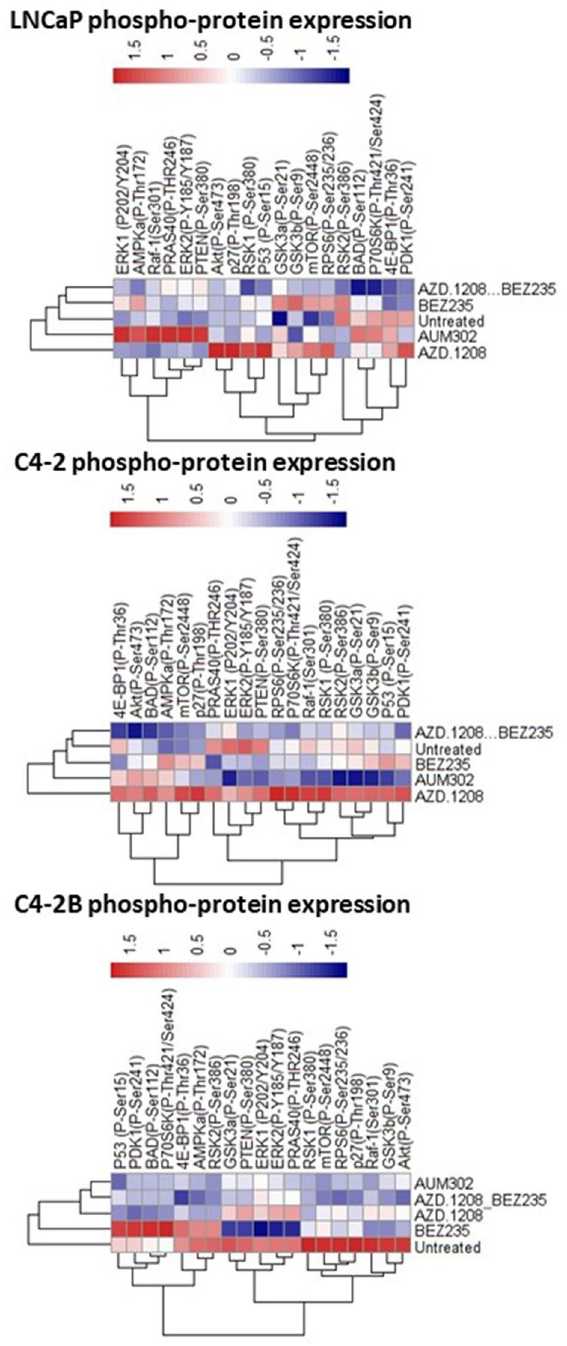
Figure 3. Inhibition of PIM and PI3K together using either a combination of AZD-1208 together with BEZ235, or AUM302 alone, showed superior inhibition of phosphoprotein levels than any of the monotherapies, correlating with increased aggressiveness. LNCaP, C4-2 and C4-2B cells were cultured and treated for 4 h with PIM inhibitor AZD-1208 or PI3K/mTOR inhibitor BEZ235 alone, a combination of AZD-1208 and BEZ235, or multikinase inhibitor AUM302, for four hours each. Proteins were then extracted and quantified using Bradford assay. Changes in phosphoprotein levels were quantified using a phosphokinase array which included key proteins of interest of the PI3K pathway. The results were normalised to positive and negative controls (a controlled amount of detection antibody or no antibody on the array), and then to the untreated control. One- way ANOVA and a Tukey post-test were used to determine the significance of the findings, included in full in Supplementary Figs. S5, S6 and S7. Heat-maps were generated using R statistical package version 3.3.1. Blue indicates downregulation of phosphoprotein expression, white no change, and red upregulation of